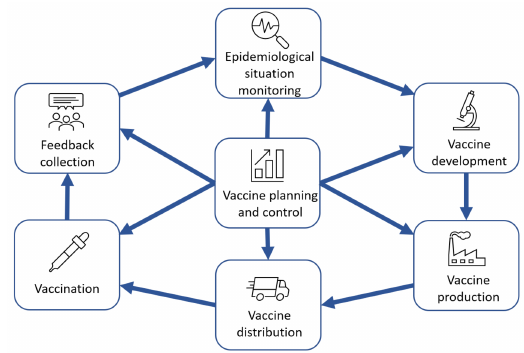
Figure 2. Vaccine lifecycle: business